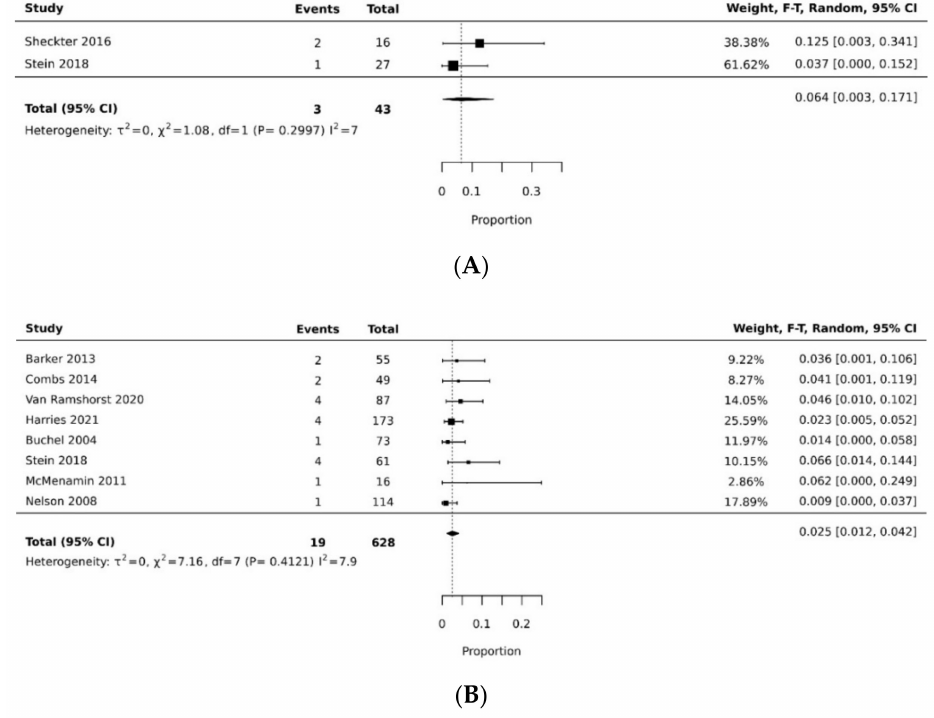
Figure 9. ( A ) Forest plot for total flap necrosis for gracilis [26,37]. ( B ) Forest plot for total flap necrosis for VRAM